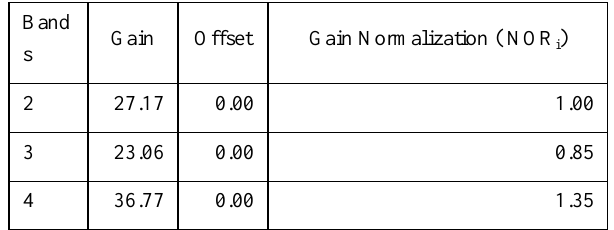
Table 7. Gain, Offset, and Gain Normalization factors.